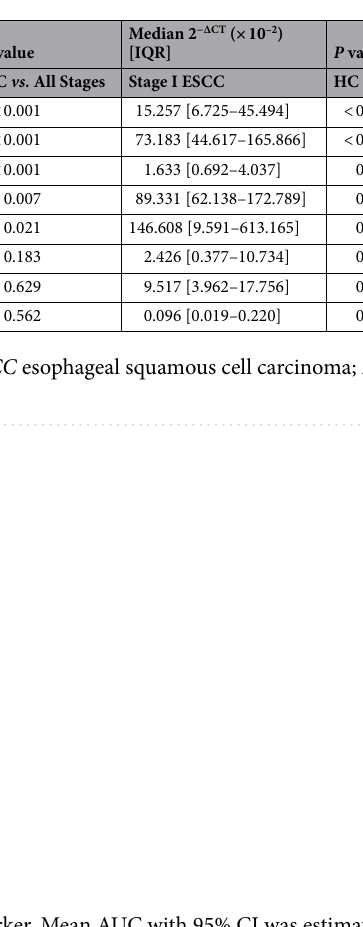
Table 3. Internal cross-validation of urinary miRNA biomarker. Mean AUC with 95% CI was estimated by bootstrap method that resampled the model 1000 times. ESCC esophageal squamous cell carcinoma; AUC area under the curve; 95% CI 95% confidence